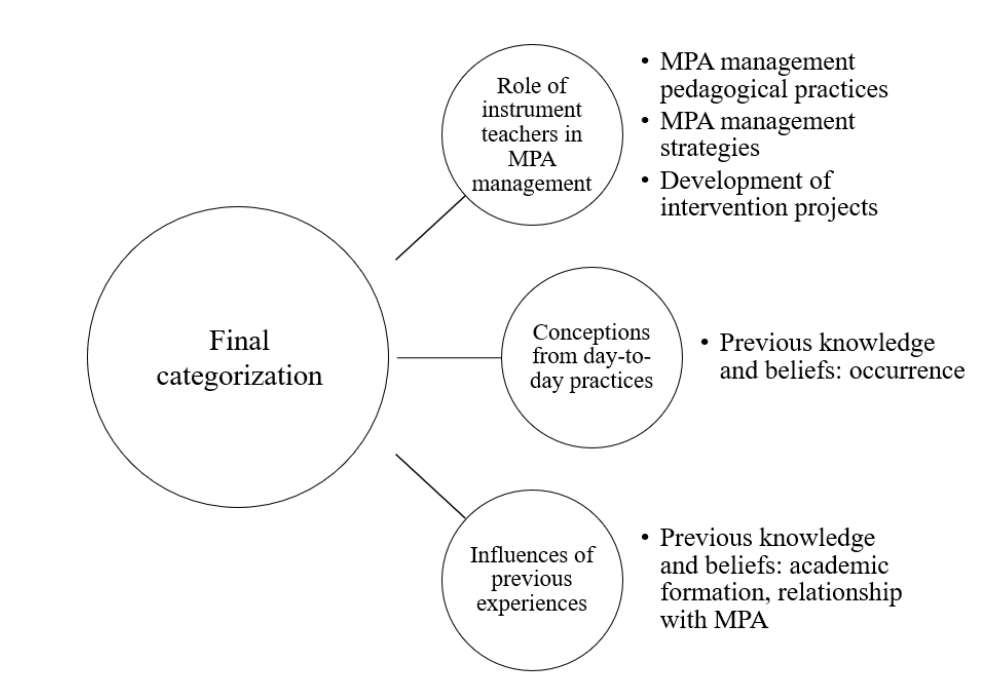
Figure 1: Final categorization for regrouping and interpretation of data. Source: